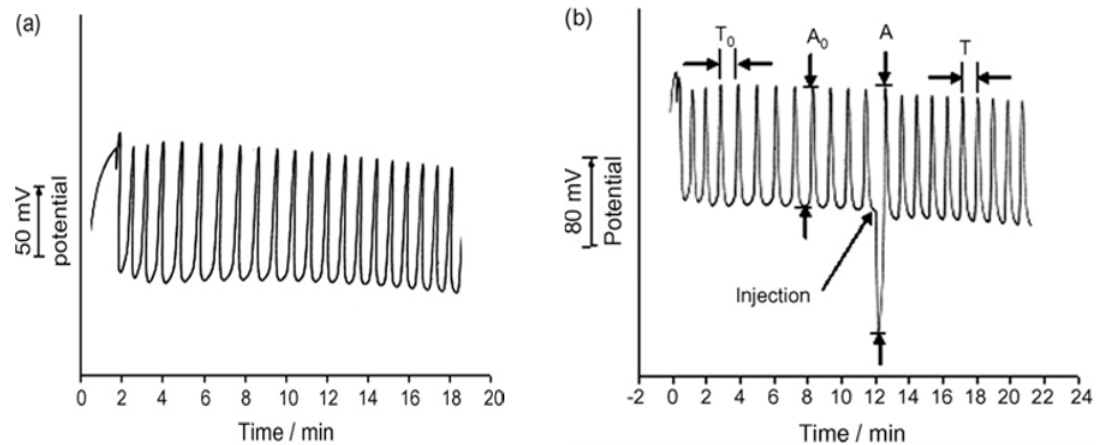
Figure 1. Typical oscillation profiles in the absence and presence of pyrogallol using a platinum electrode: (a) [pyrogallol] = 0.000 M, (b) [pyrogallol] = 7.5×10 −6 M. Common conditions: [NaBrO 2.76×10 −3 M. (Adapted from